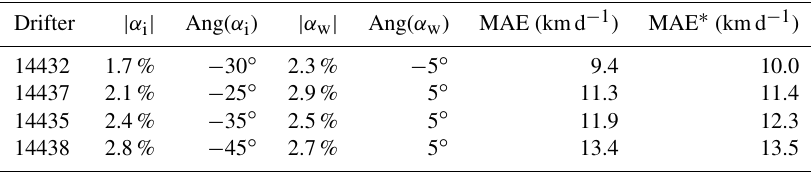
Table 1. Best fit for leeway coefficients using the CAPS forcing. MAE ∗ is the mean absolute error using leeway values of α i = 0 . 02 e − iπ/ 6 and α w = 0 . 03. Negative angles imply clockwise direction relative to wind.